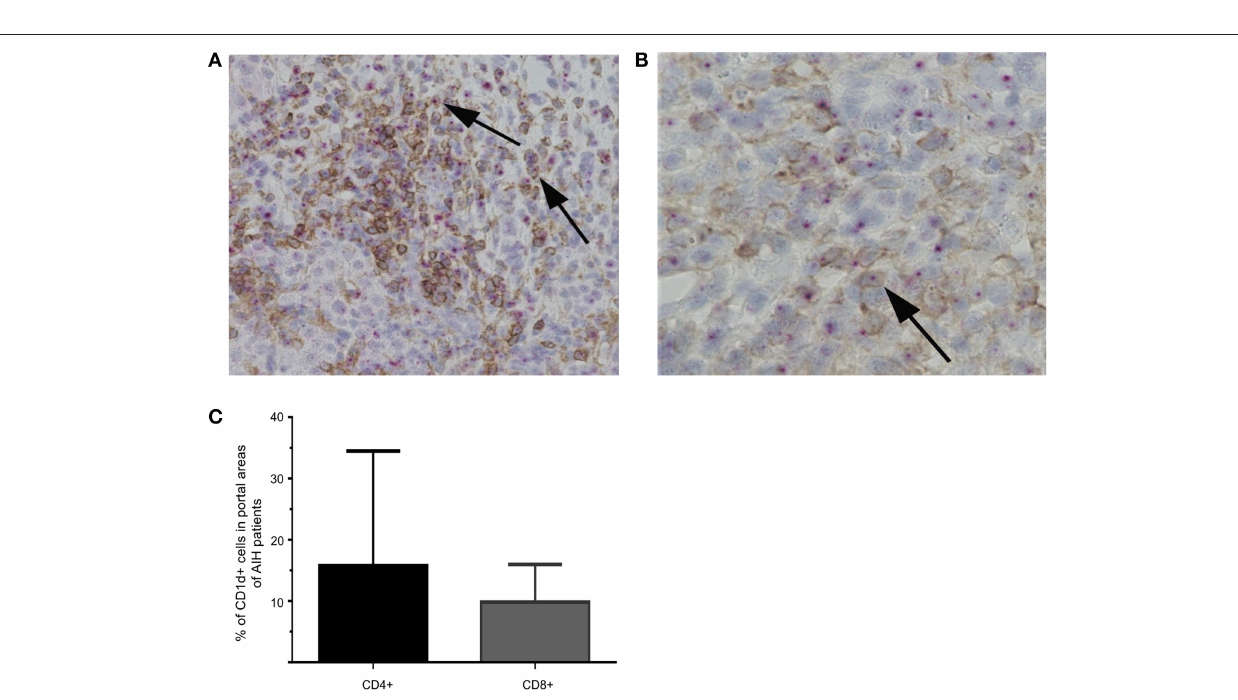
FIGURE 9 | Representative in situ stainings of CD1d-RNA in liver biopsies. Representative stainings of CD1d-RNA (purple dots, see arrows) with co-stainings of hepatocytes ( A , brown = CK18) and cholangiocytes ( B , brown = CK7) and in infiltrating lymphocytes in portal areas (C) . Representative analyses of CD1d-RNA expression (see arrows) in infiltrating lymphocytes in portal areas of an AIH patient (D) and a patient with DILI (E) .